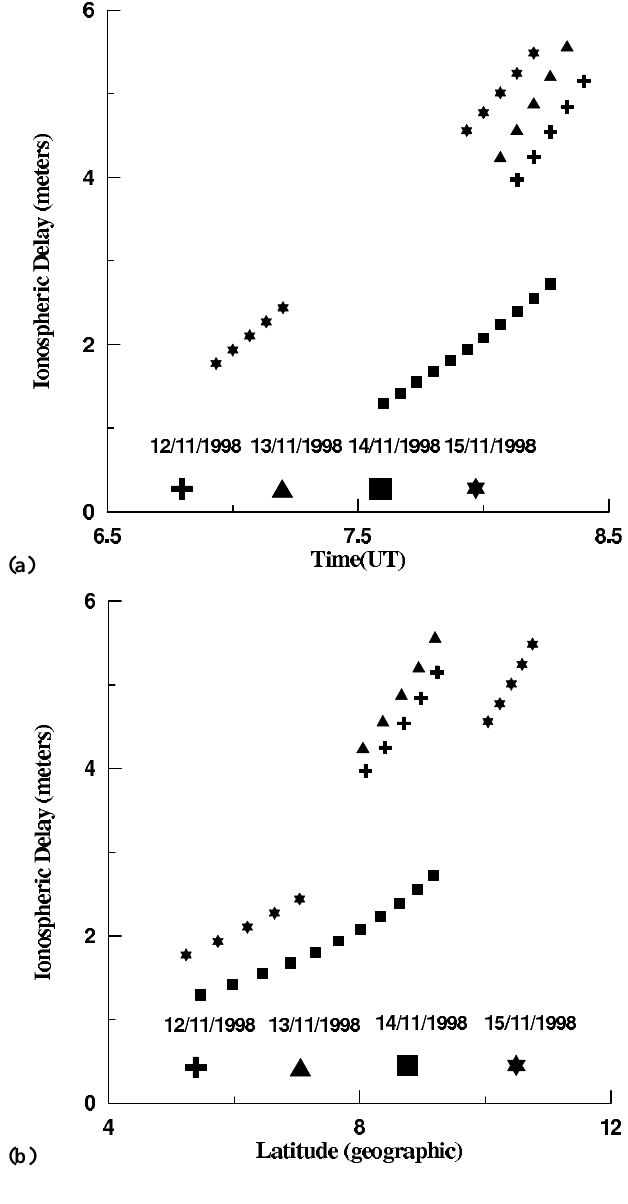
Fig. 4. Observation of ionospheric delay made using satellite GPS PRN22 at Bangalore, (a) time variation, (b) latitudinal variation on different days during storm